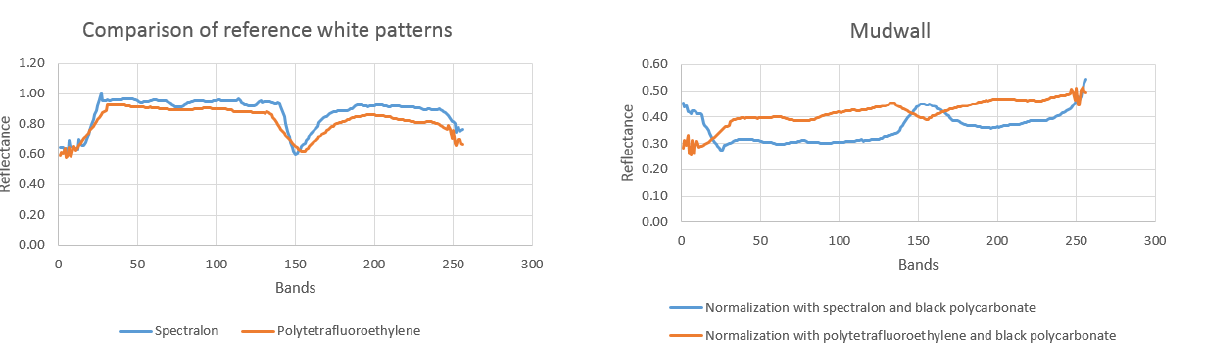
Figure 12. Comparison of the spectral signatures of the spectralon and polytetrafluoroethylene. Normalization in both cases with polycarbonate as reference black.